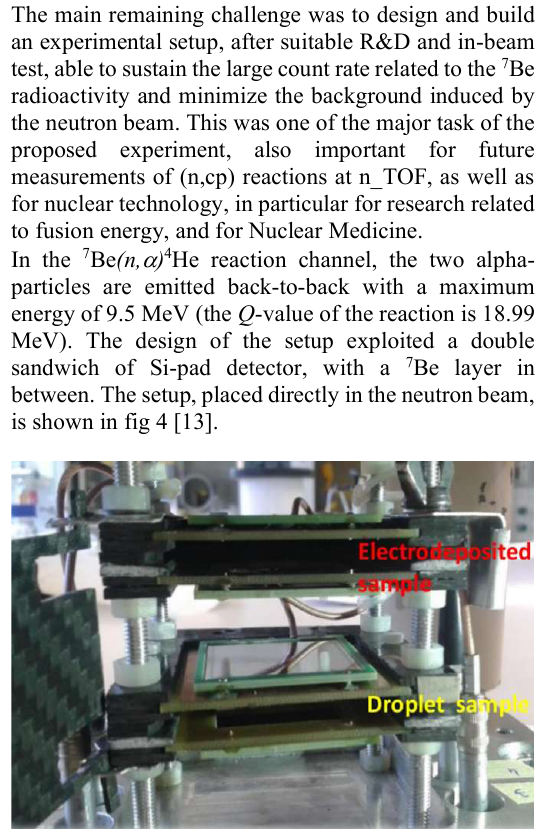
Fig. 4. Experimental setup. The two 7 Be targets have been inserted in between a couple of Si-pads, detecting alpha- particles in coincidence. All the system has been placed in line with the n_TOF n-beam, for further details see ref. [13].